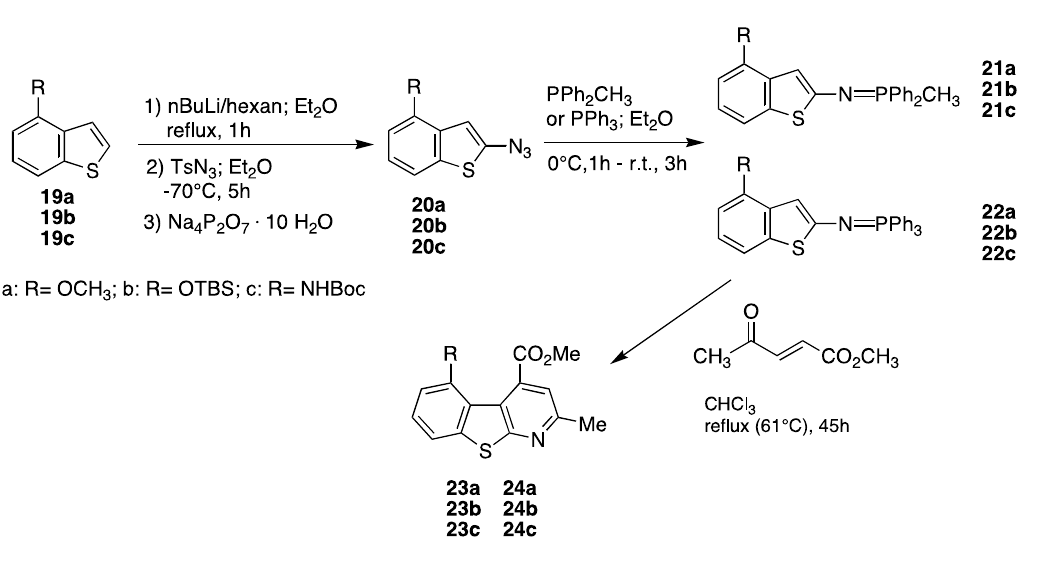
Table 2. Synthesis of 4-carbomethoxy-6-hydroxy-(or amine)-2-methylbenzothienopyridines. Phosphorane Benzothienopyridine (%yield) Entry Azide (%yield) (%yield) 1 26a (55%) 27a (58%) 29a (35%) 2 26b (28%) 27b (79%) 29b (13%) 3 26c (62%) 27c (49%) 29c (no product) 4 26a (55%) 28a (74%) 30a (52%) 5 26b (28%) 28b (81%) 30b (58%) 6 26c (62%) 28c (no product) 30c (no